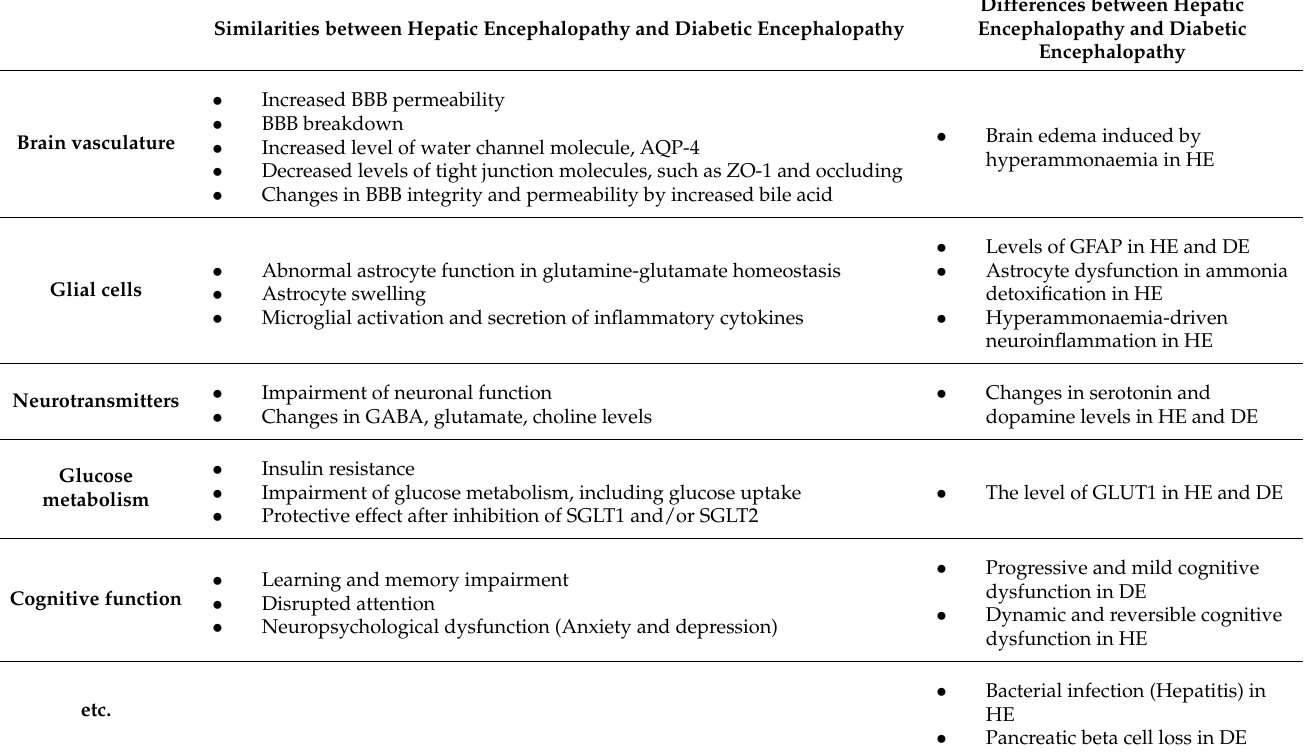
Table 1. Similarities and differences between hepatic encephalopathy and diabetic encephalopathy. Similarities between Hepatic Encephalopathy and Diabetic Encephalopathy